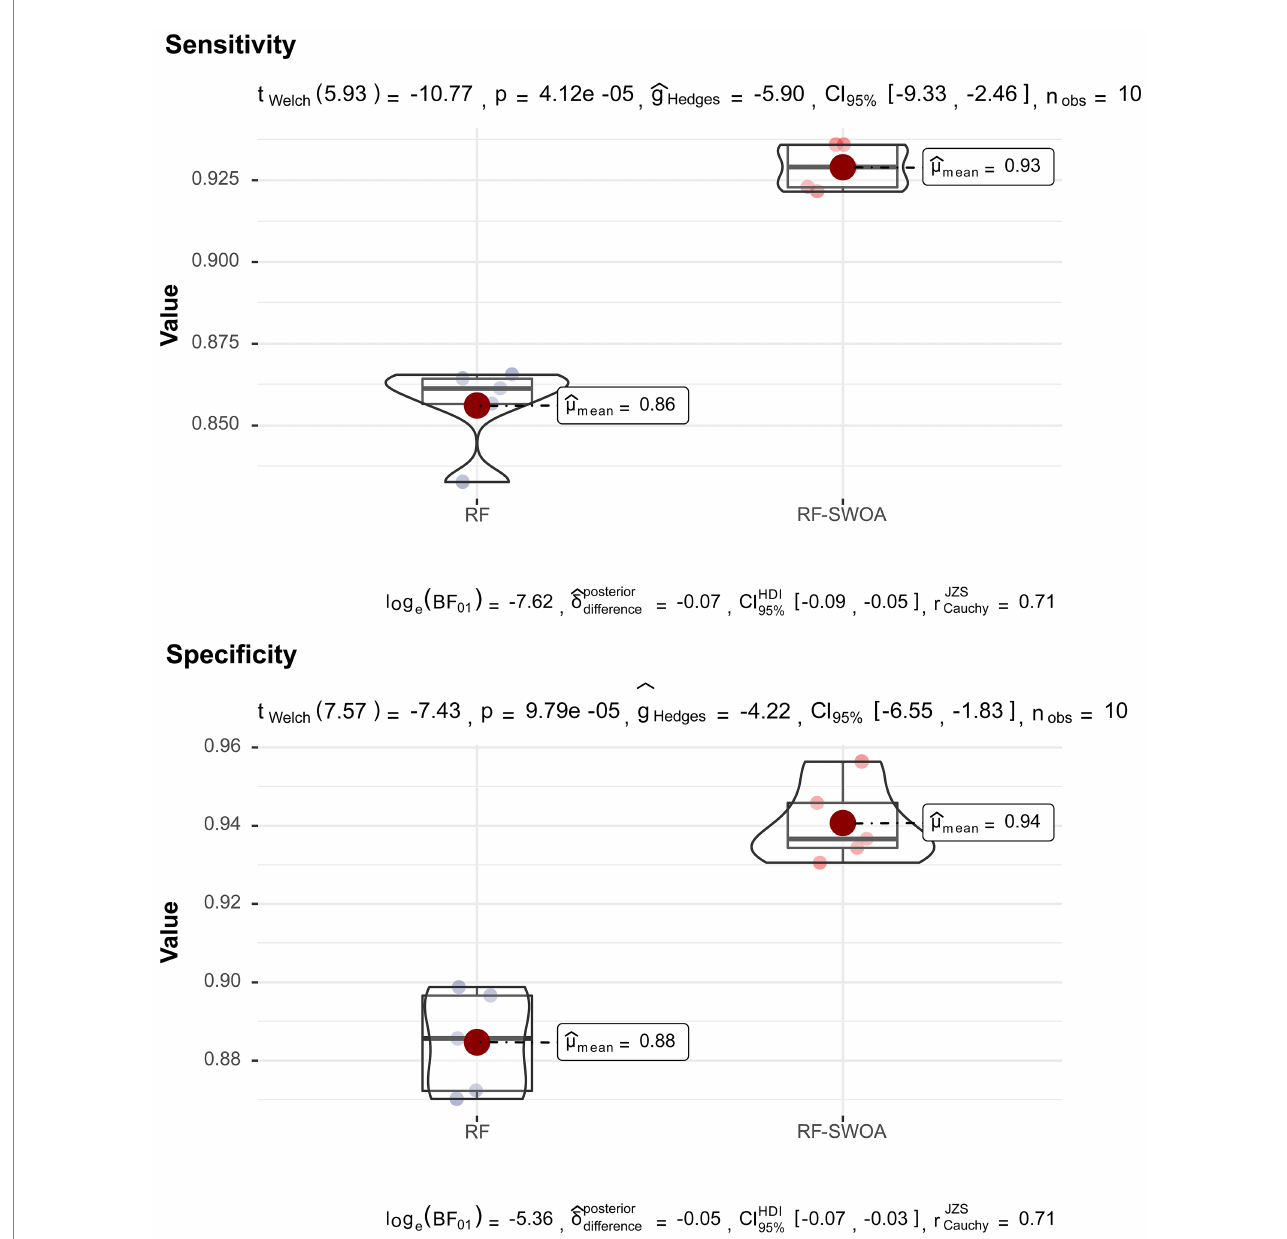
FIGURE 7 Sensitivity and specificity tests of RF and RF-SWOA models. The upper part of the panel shows the statistical test results of frequentist analysis, and the lower part of the panel shows the statistical test results of Bayesian analysis. The results follow the gold standard of statistical reporting (Patil,